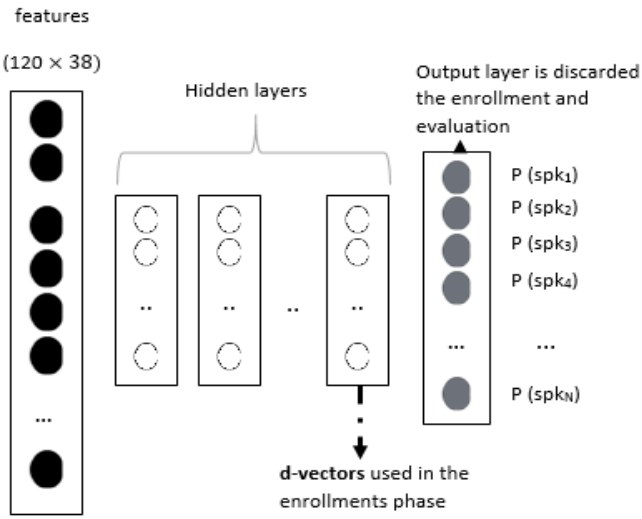
Figure 5. Background DNN topology for learning speaker-specific features [33].